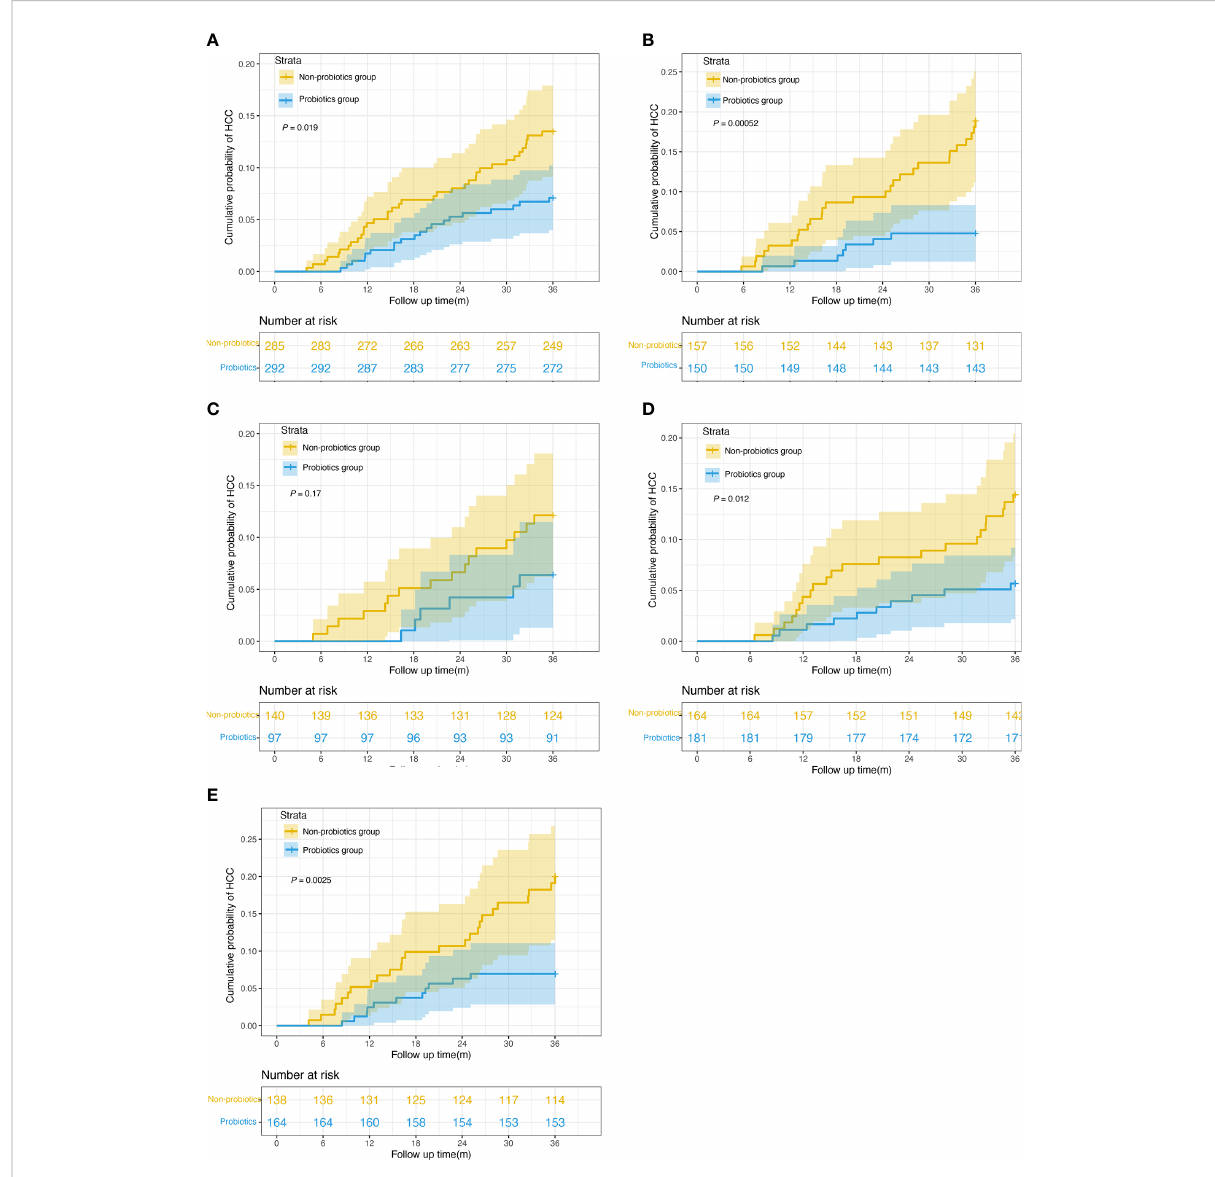
FIGURE 3 Kaplan-Meier survival curves of risk strati fi cation according to MELD score and CTP classi fi cation. (A) Cumulative incidence of HCC in probiotics users and nonusers with MELD scores < 10 (n = 577, 6.8% vs. 12.6%, log-rank test P = 0.019). (B) Cumulative incidence of HCC in probiotics users and nonusers with MELD scores ≥ 10 (n = 307, 4.7% vs. 16.5%, log-rank test P = 0.00052). (C) Cumulative incidence of HCC in probiotics users and nonusers in CTP class A (n = 237, 6.2% vs. 11.4%, log-rank test P = 0.17). (D) Cumulative incidence of HCC in probiotics users